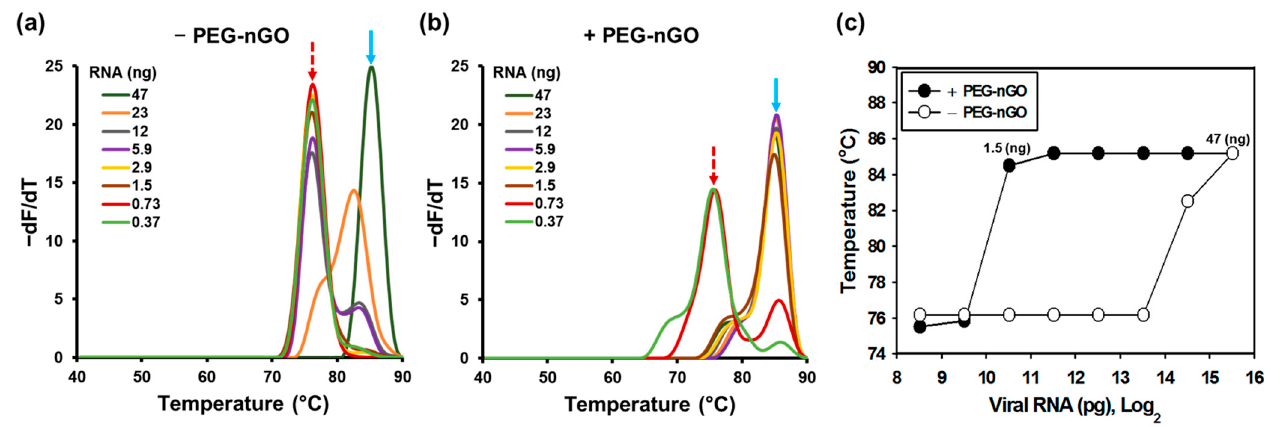
Figure 4. Effect of PEG-nGO on specificity of EG-based qPCR. ( a ) Melting curve analysis of qPCR- amplified products with serially diluted target (IFZ B) RNA (47 ng to 0.37 ng) in the absence of PEG-nGO. ( b ) Melting curve analysis of qPCR-amplified products with serially diluted target RNA (47 ng to 0.37 ng) in the presence of PEG-nGO. Red dotted arrow and cyan arrow represent nonspecific- and specific-amplicon dsDNA peak, respectively. ( c ) Changes in T m values representing amplicon dsDNA peak with various target RNA concentrations in the absence or presence of PEG-nGO (open and closed circles, respectively).